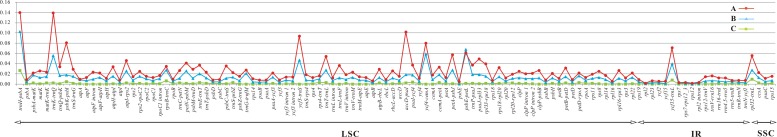
Comparison of the nucleotide variability (Pi) values in (A)
Gentiana, (B) sect. Kudoa, and (C) sect. Kudoa except ser. Monanthae. A total of 114 regions (49 coding genes, 9 intron regions, and 55 intergenic regions) greater than 200 bp in size were generated in both comparisons.